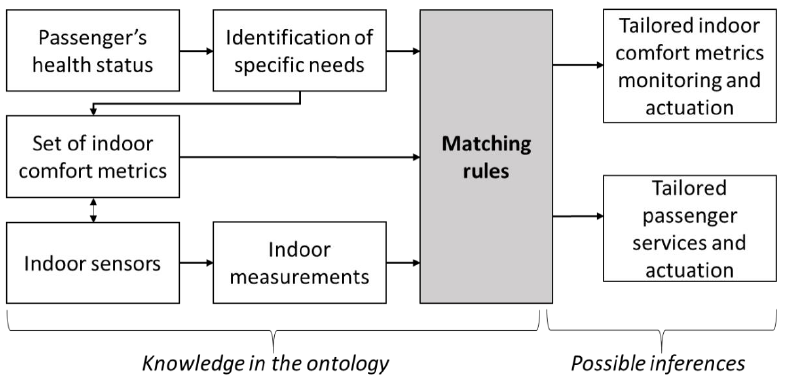
Figure 5. A schema representing the knowledge to be formalized into the ontology for Case 2, and a list of expected